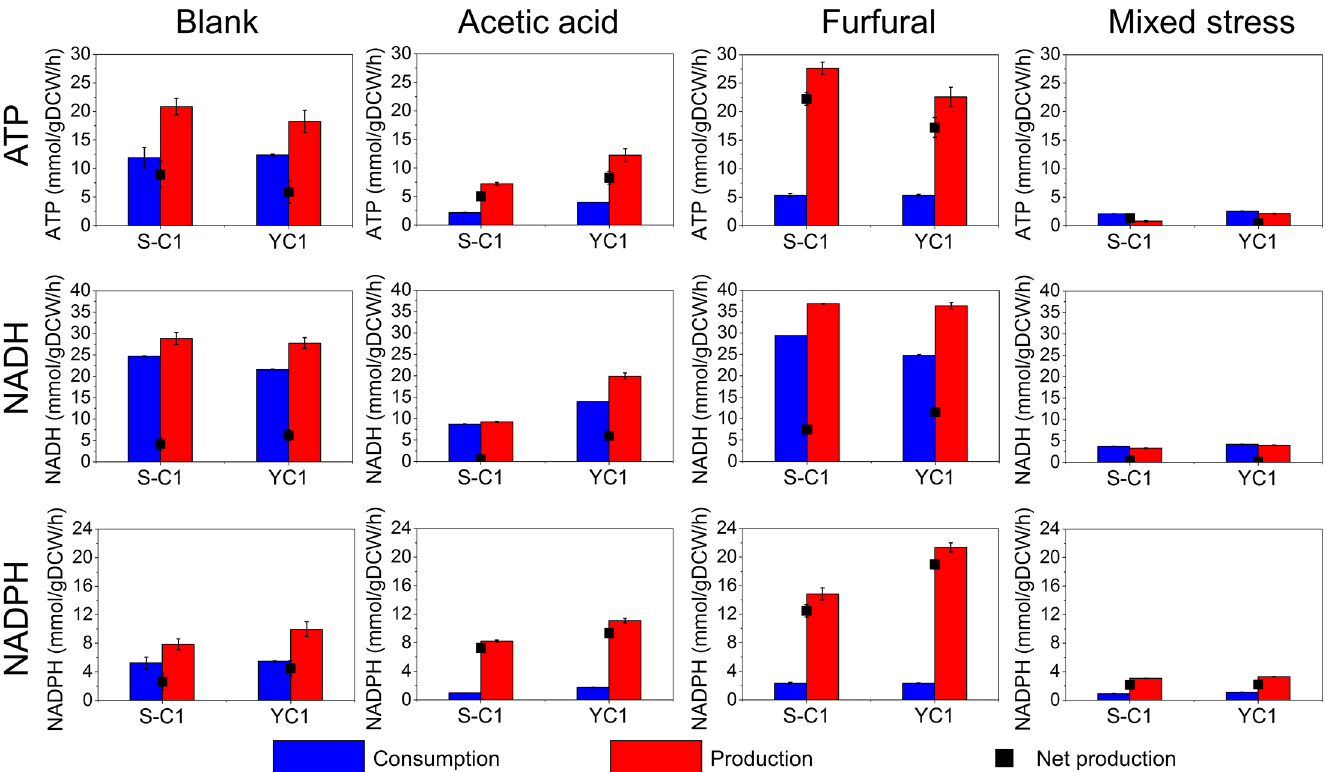
Fig 2. Production and consumption of cofactor and energy. The consumption (blue bar), production (red bar), and net production (black dots) of ATP, NADH, and NADPH are shown for different stress conditions. The error bars present the standard deviations, which can be too small to be seen.